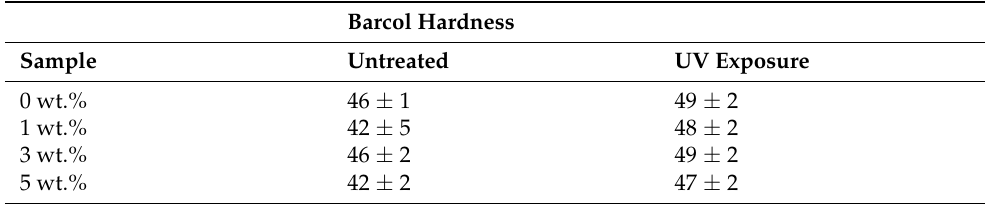
Table 4. Barcol hardness values of the samples before and after the UV treatment.